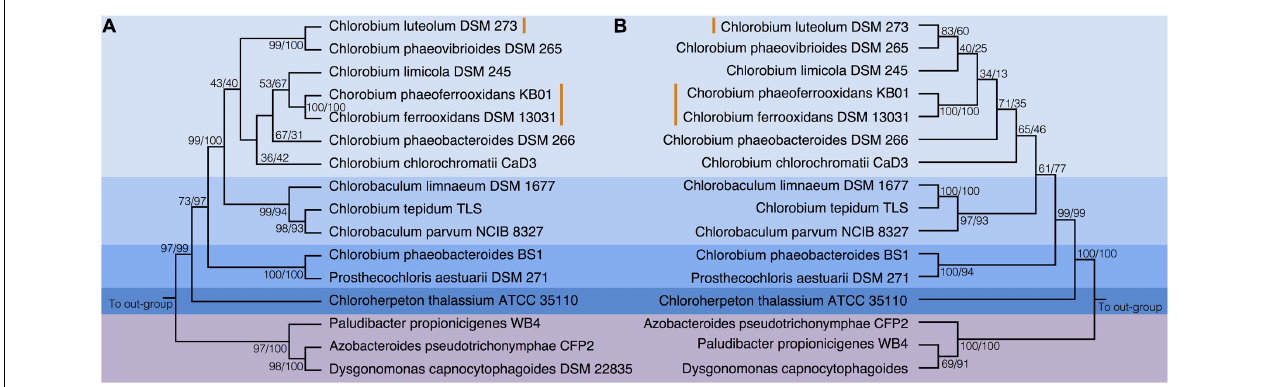
FIGURE 3 | Phylogenies of the Chlorobi and Bacteroidetes using (A) the concatenated NifDKH proteins and (B) 16S rRNA with bootstrap values shown at each node (maximum likelihood/maximum parsimony). The blue colors delineate the organisms of the Phylum Chlorobi, with each shade representing a different genus, while the purple color delineates the Phylum Bacteroidetes. The orange lines indicate the position of the photoferrotrophic Chlorobi. The trees were rooted with four cyanobacterial organisms. Note: Azobacteroides pseudotrichonymphae CFP2 is abbreviated from Candidatus Azobacteroides pseudotrichonymphae genomovar.